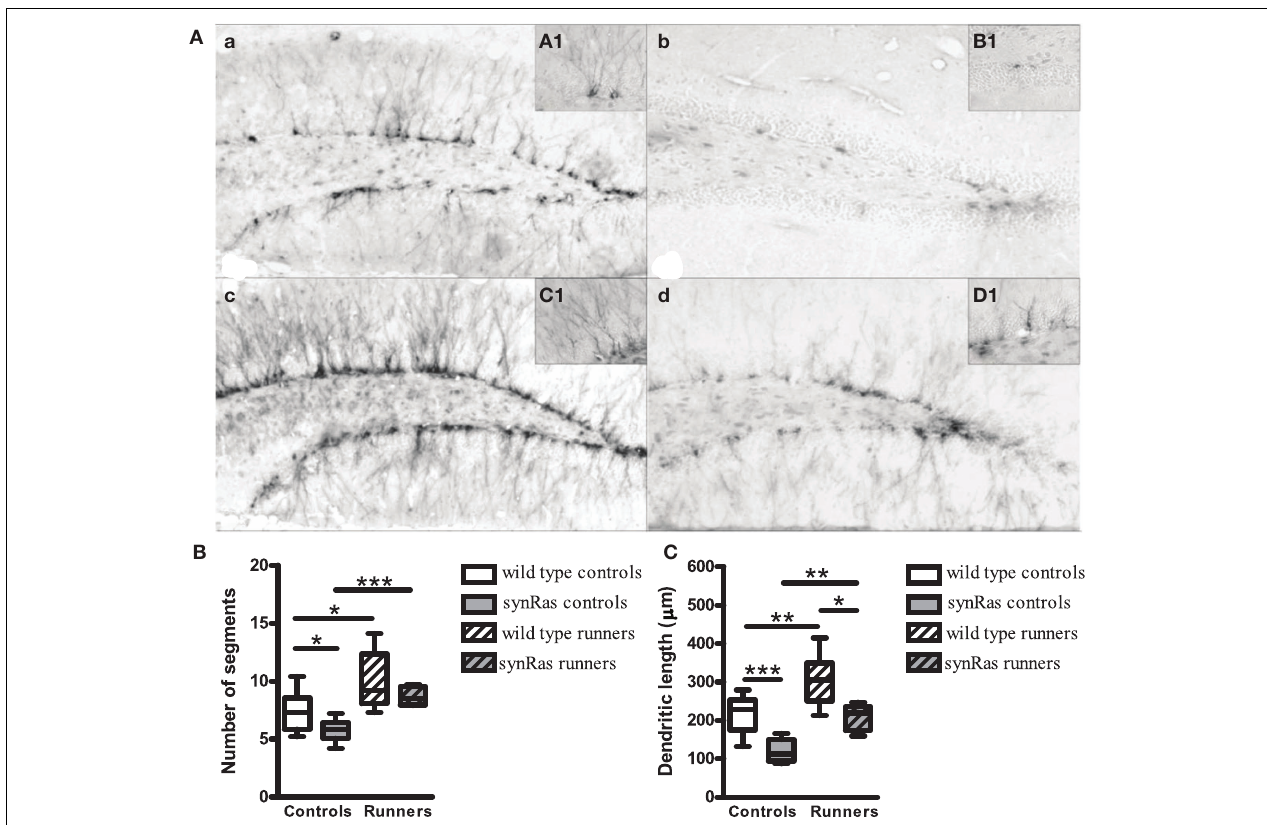
FIGURE 2 | Effects of physical activity on the dendritic arborisation of immature doublecortin-labeled neurons. (A) Representative photographs and islets of doublecortin-labeled cells at high magnifi er ( × 100) in wild type controls ( n = 6) (a) , synRas controls ( n = 6) (b) , wild type runners ( n = 7) (c) and synRas